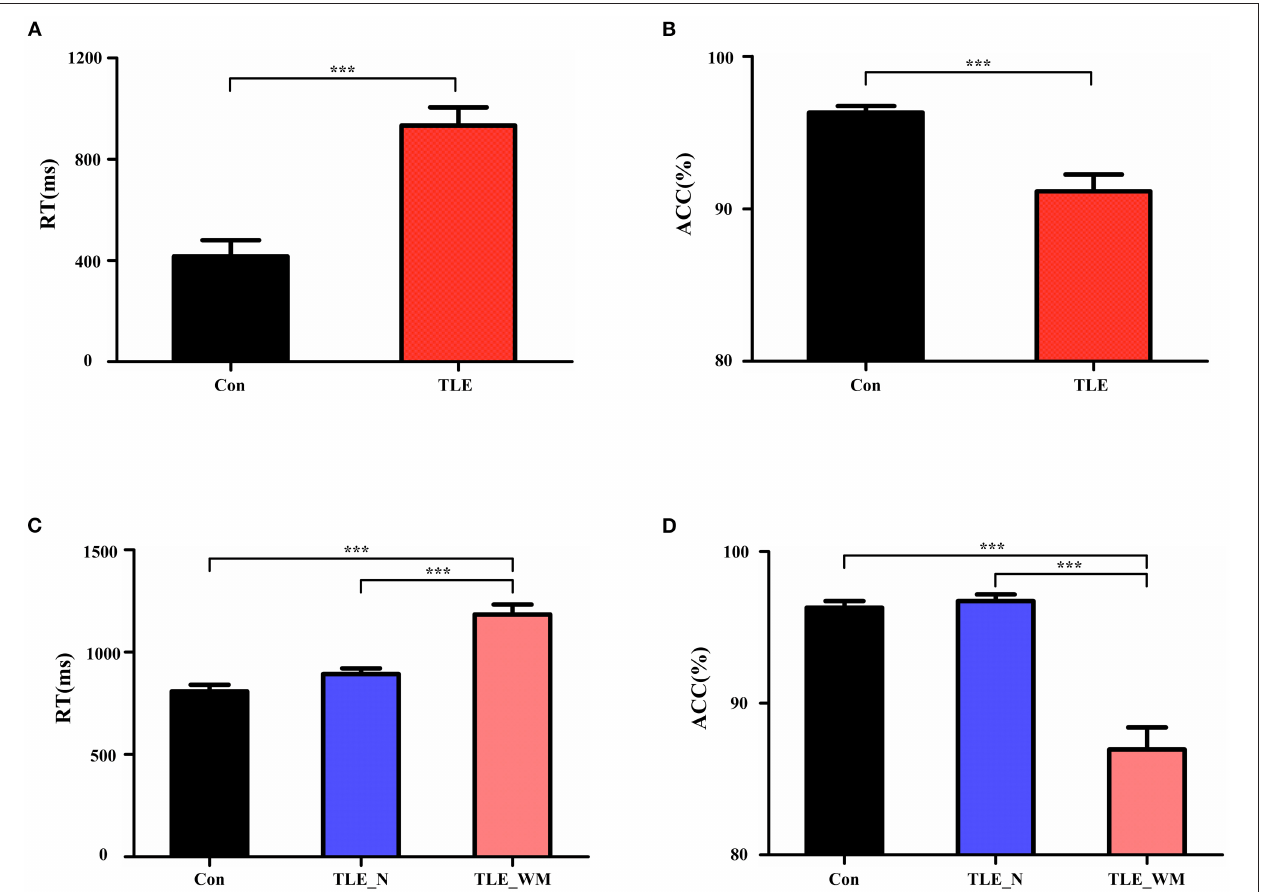
FIGURE 2 | Comparisons of task performance. (A,B) Comparisons of RT and ACC results between the TLE group and the Con group. (C,D) Comparisons of RT and ACC results between the TLE-N group, the TLE-WM group, and the Con group. *** p < 0.001.